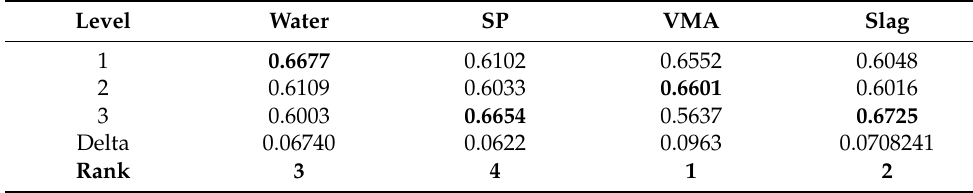
Table 11. Response table for average of GRG’s.